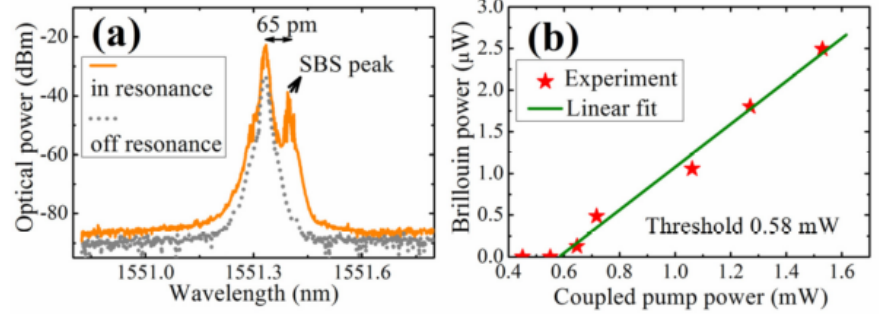
Figure 14. ( a ) Gray line: pump off resonance; yellow line: in resonance; ( b ) relationship between coupled pump power and Brillouin power. Reprinted/Adapted with permission from [82].